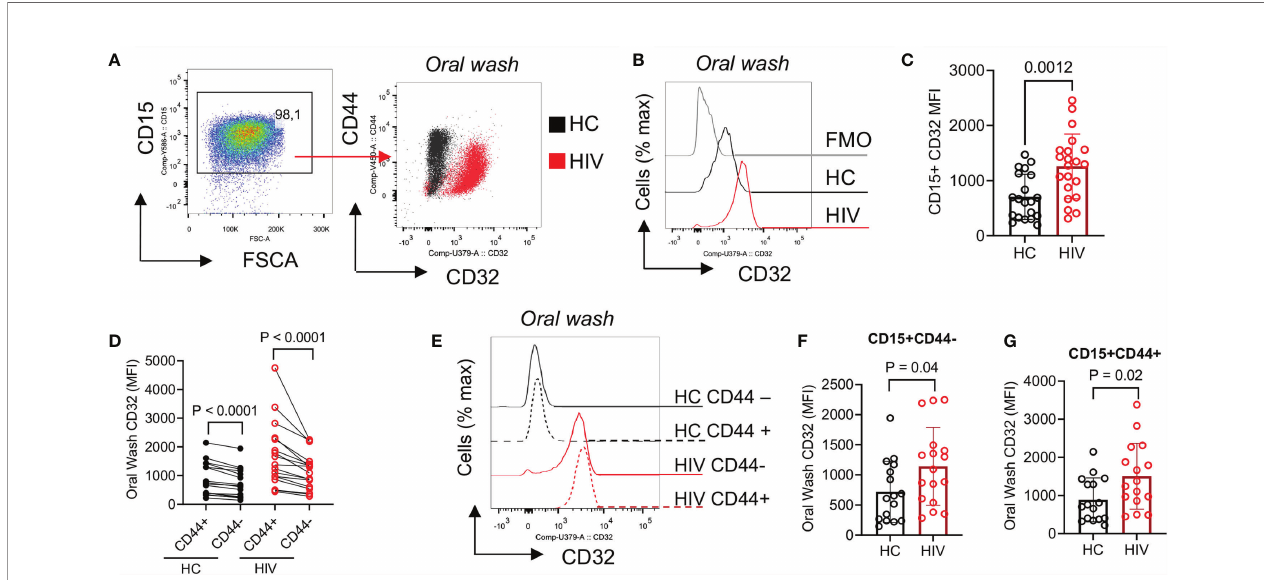
FIGURE 4 | Differential expression of CD32 on neutrophils from HIV-infected individuals versus healthy individuals. (A) Representative fl ow cytometry plots of CD32 expression on neutrophils of an HIV-infected vs. a healthy individual. (B) Representative histogram plots, and (C) cumulative data of CD32 expression (MFI) in oral neutrophils from HIV-infected vs. healthy individuals. (D) Cumulative data of CD32 expression in regards to CD44 on neutrophils of HCs vs. HIV-infected individuals. fl ow cytometry plot of neutrophils from oral washes and their coexpression of CD44 and CD32 in HIV patients shown in red and HCs in black. Note the higher expression of CD32 in neutrophils of HIV patients. (E) Representative histogram plots, and (F) cumulative data of CD32 expression (MFI) in CD44 - , and (G) CD44 + populations of oral neutrophils from HCs and HIV-infected individuals. Signi fi cance was calculated by the Kruskal Wallis